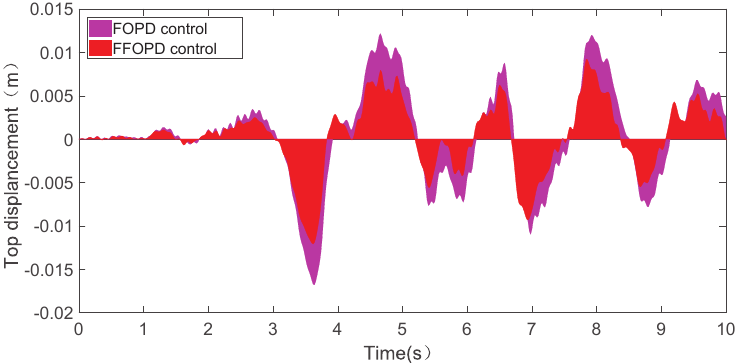
Figure 15. Top displacement curve for FOPD and FFOPD under El-Centro earthquake.